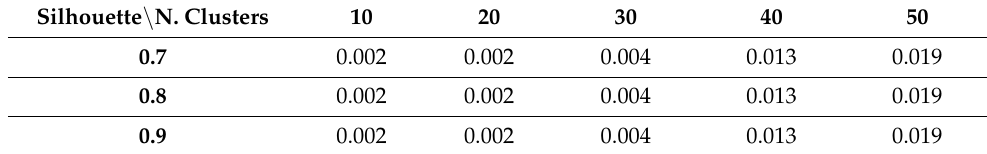
Table 49. Clustering performance in terms of silhouettes using original data. Silhouette \ N. Clusters